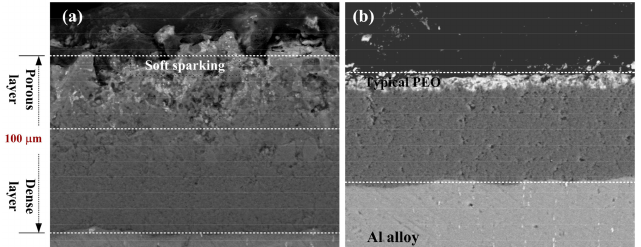
Figure 1. MorphologicaldifferencebetweentwoPEOcoatingswithandwithoutsoftsparking. Thealuminum alloy surfaces were treated with PEO in a prototype solution. The coating ( a ) with soft sparking is thick, ~100 µ m, in which the dense inner (compact) layer consists of alumina; the porous layer comprises silicates, alumina, or mullite. The coating ( b ) without soft sparking is ~47 µ m in